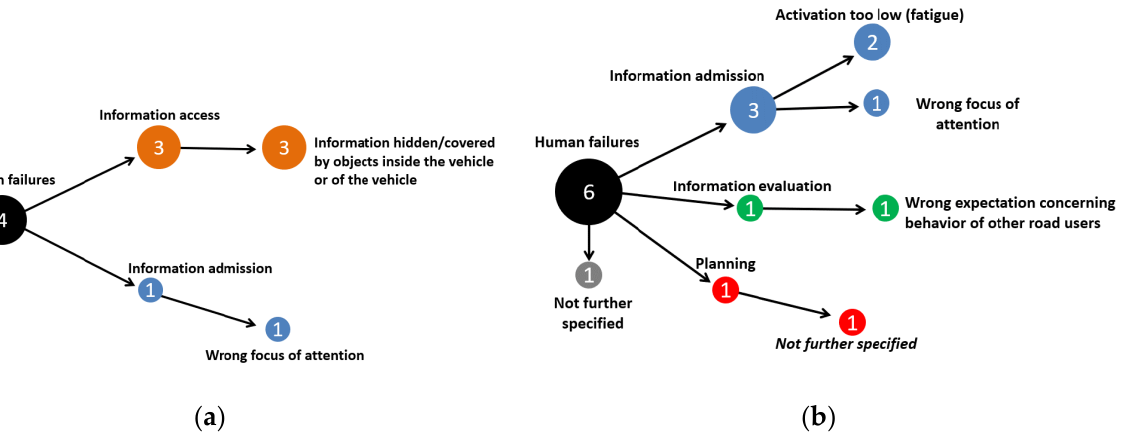
Figure 15. ACAS analysis of truck drivers ( a ) and pedestrians ( b ) in Scenario 3 (pedestrian crossing crashes).